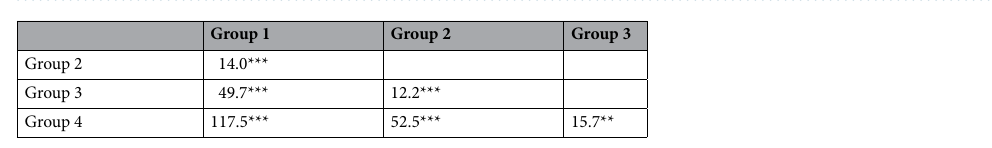
Table 6. Distances of Mahalanobis and statistical significant of Fisher. **,***indicates significance at p < 0.01 and p < 0. 001 respectively.